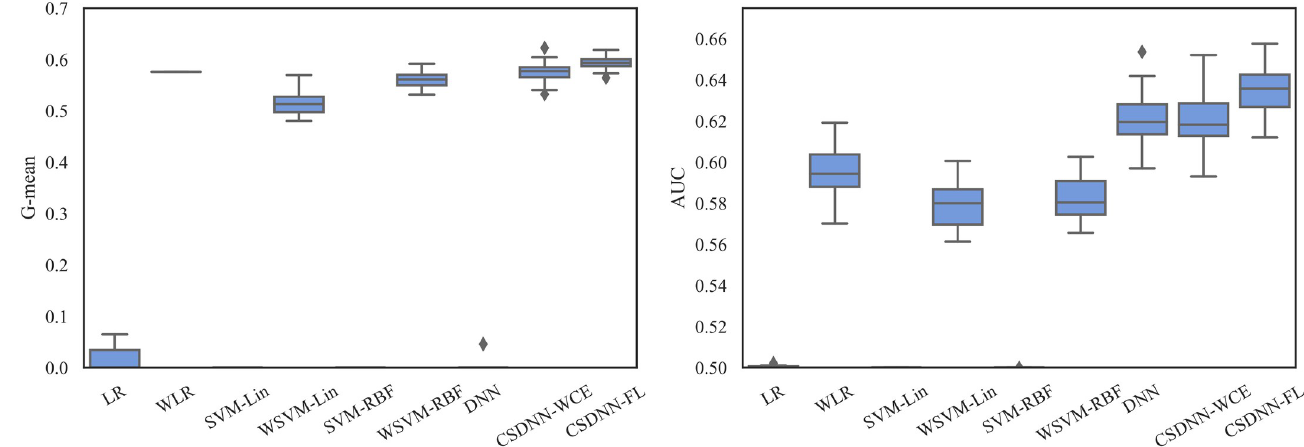
Fig 28. Robustness of CSDNN-FL and CSDNN-WCE in comparison to other ML algorithms for Oklahoma dataset in terms of G-mean (left) and AUC (right).